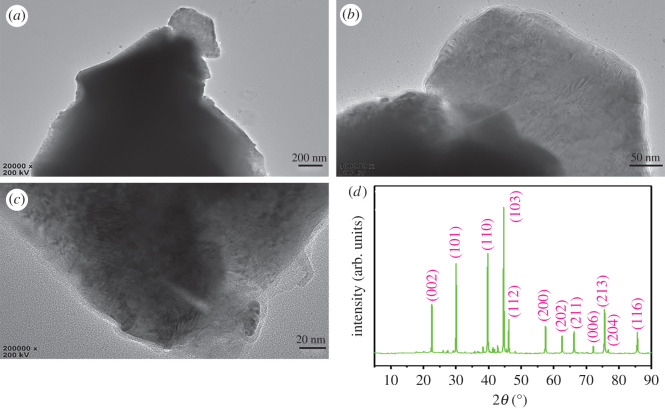
(a–c) Representative TEM image of MoSi2 ceramic; (d) XRD patterns of MoSi2 ceramic.